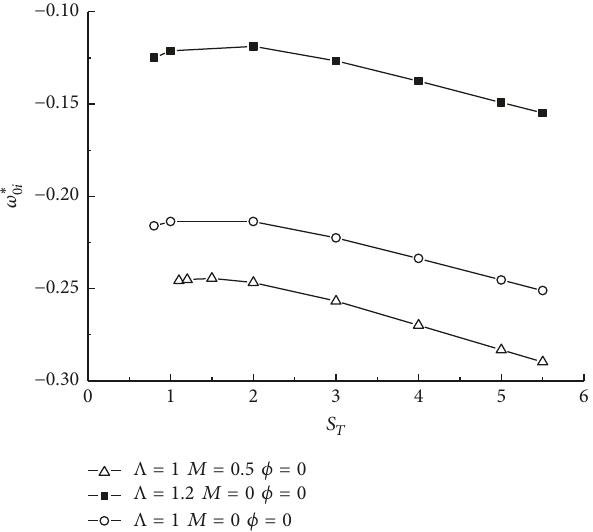
Figure 4: The variation of absolute growth rate with temperature ratio 𝑆 𝑇 .